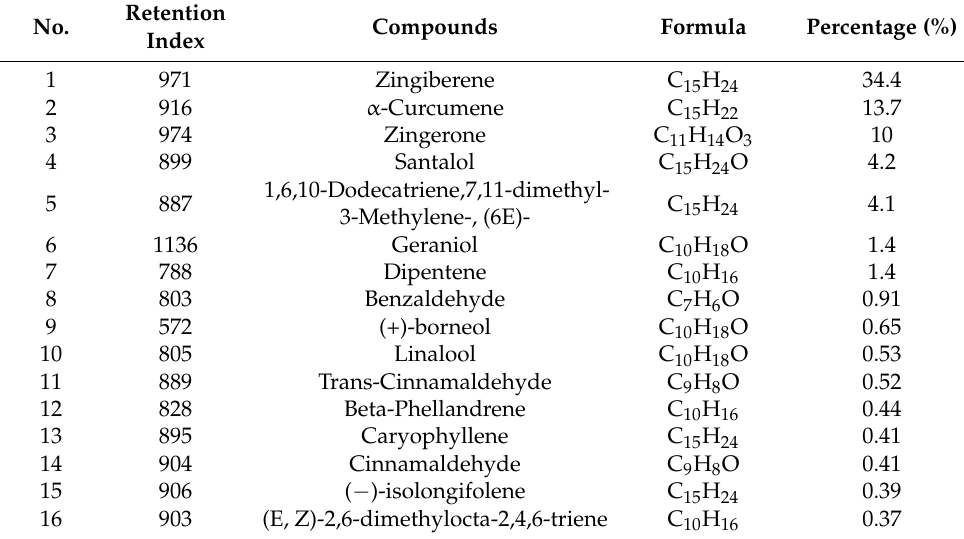
Table 1. Analysis of volatile components of ginger essential